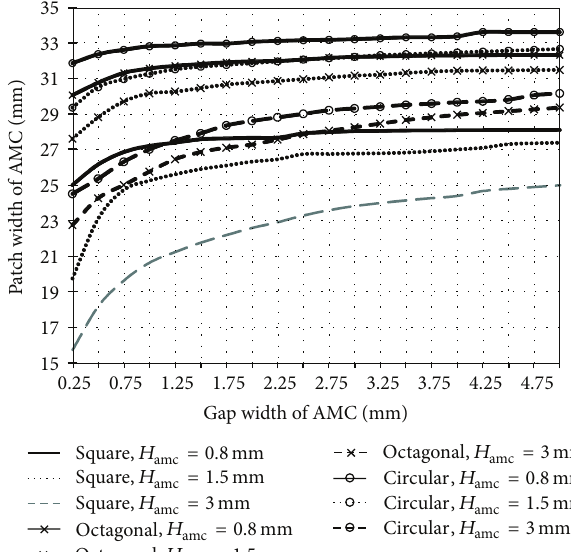
Figure 5: Theparametric study of thepatch width and the gap width of AMC structures at the operating frequency of 2.45